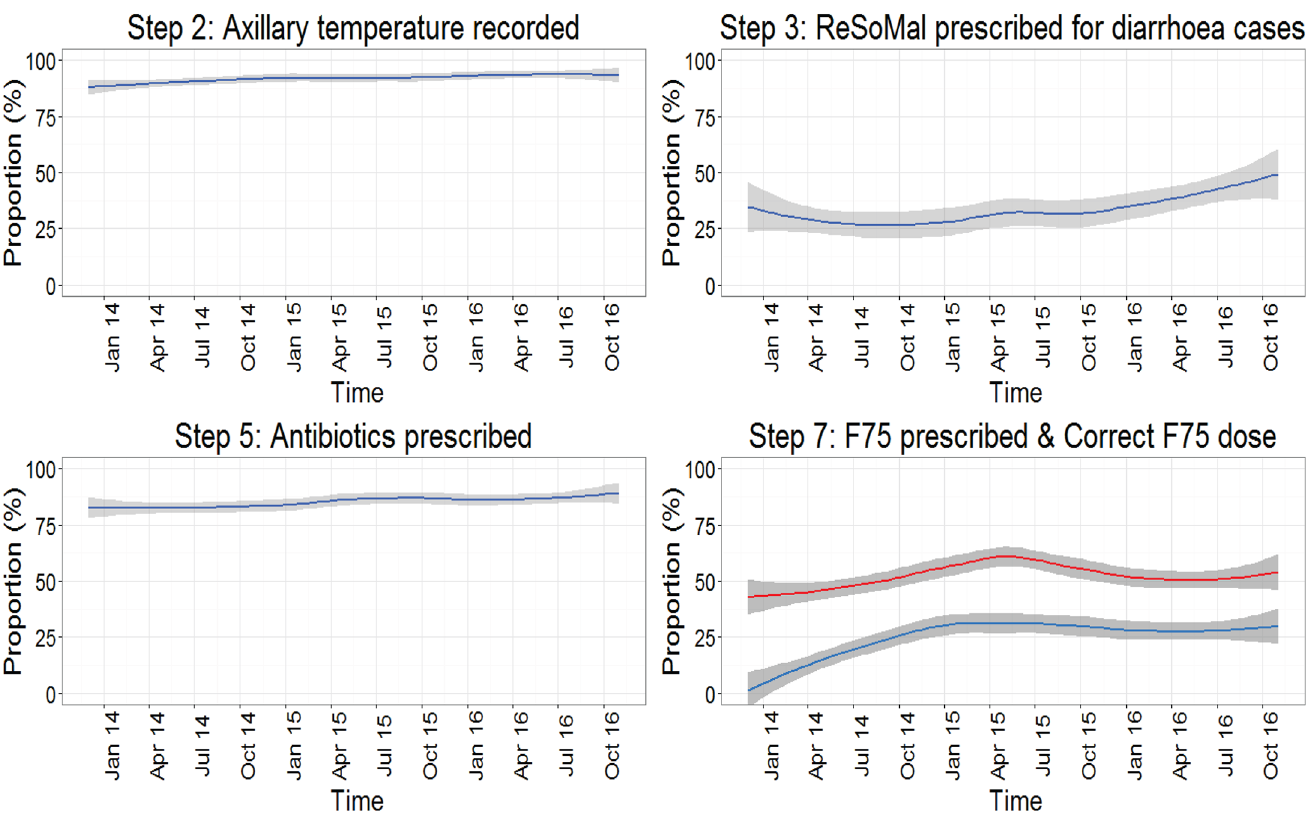
Fig 3. Cluster adjusted mean performance (solid line) with 95% confidence band portraying adherence to recommended guidelines over time for SAM management steps with sufficient data. Step 7: Red line is F75 prescribed and blue line is correct F75 dose.